Question: Provide a one-line summary of what is displayed.
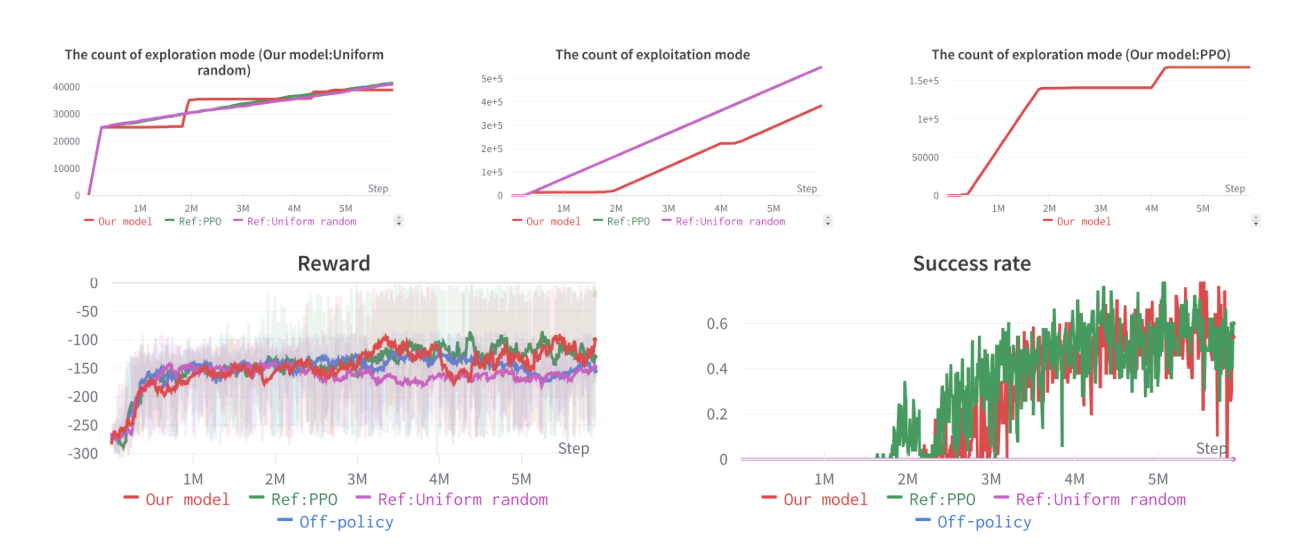
Answer: The count of exploration modes and exploitation and the reward and success rate of higher level policy for our model, Ref:Uniform random, Ref:PPO and HIRO in Ant Fall